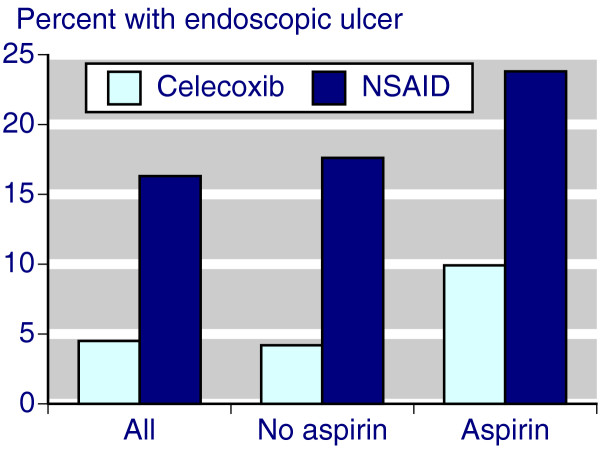
Endoscopically identified ulcers in patients taking celecoxib and NSAID, with and without prophylactic low-dose aspirin. NSAID, nonsteroidal anti-inflammatory drug.